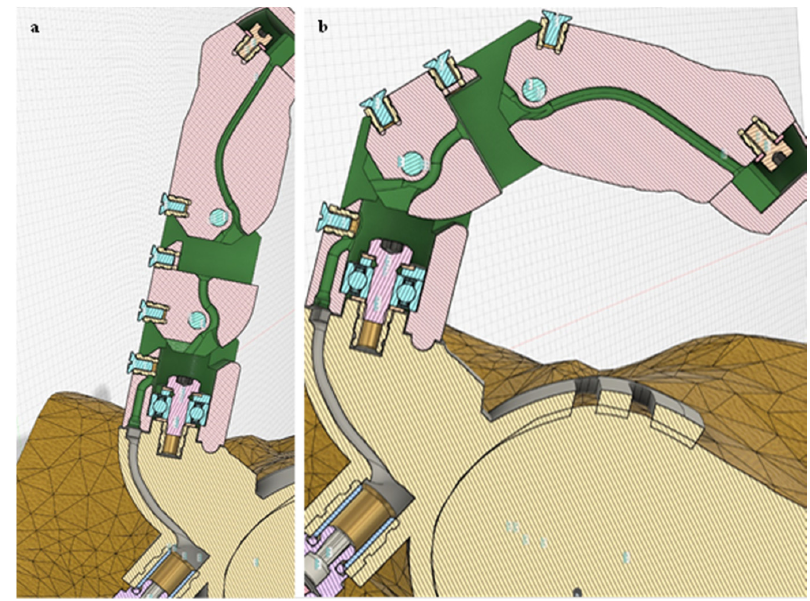
Figure 6. Third thumb in ( a ) stretched and ( b ) bent position. To enable rotation of the thumb, a deep groove ball bearing (623-2Z, 3 mm ID × 10 mm OD × 4 mm wide, light blue part in Figure 6) was pressed into the borehole of the base phalanx. The latter was connected with the supporting system (beige part in Figure 5) by an M3 screw. Annular grooves for a pressure spring (Figure 7a) were added to the supporting system as well as to the base phalanx, letting the thumb rotate back into the neutral position when rotated. The length of the base phalanx is 27.3 mm. The intermediate phalanx can be bent by 50 ◦ with respect to the base phalanx and has a height of 28.8 mm. The end phalanx can be bent by 45 ◦ with respect to the intermediate phalanx. On its tip, it has an M2 borehole on which a cover is plugged.